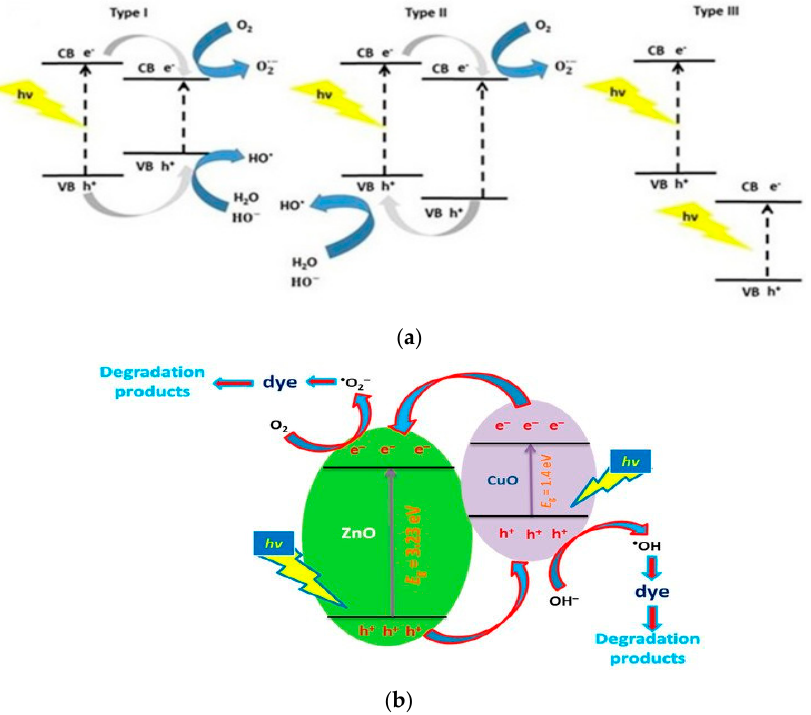
Figure 10. ( a ) Energy band alignments of type-I, type-II, and type-III heterojunctions. Reproduced